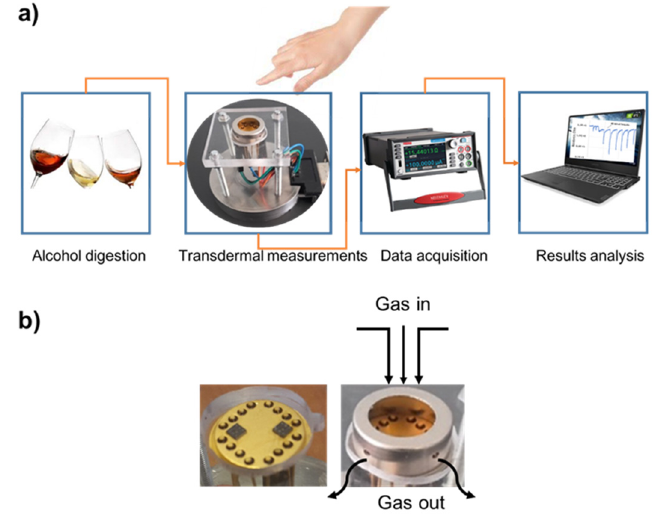
Figure 3. ( a ) Experimental set up of the transdermal alcohol detection and ( b ) the detection cell images.